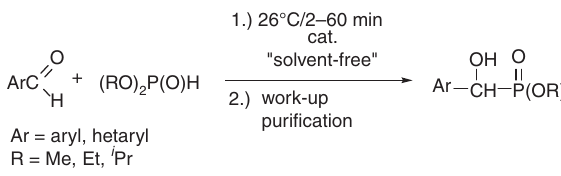
Scheme 1: General protocol for the synthesis of α -hydroxy - phosphonates.